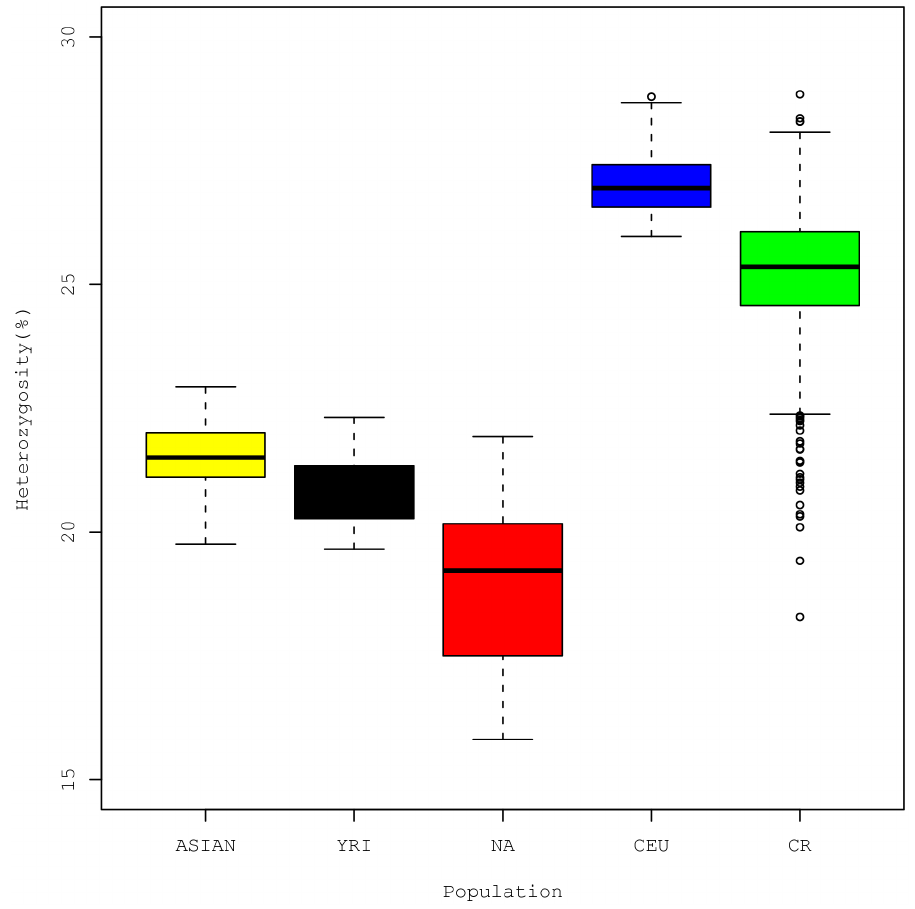
Figure 1. Mean sample heterozygosity by population. Mean sample heterozygosity for each sample was calculated as the number of heterozygote genotypes divided by the total number of non-missing genotypes for the set of 2,663 structure inference SNPs. The sample sizes are 89 ASIAN, 59 YRI, 56 NA, 60 CEU and 1301 CR, respectively.